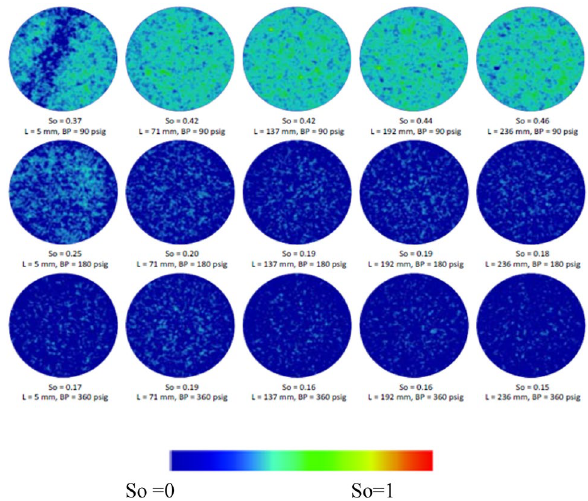
Fig. 9 CT images showing oil saturation distribution. First row: oil saturation distribution after imbibition; second row: first saturated brine flooding; third row: second saturated brine flooding (Alizadeh et al. 2011)